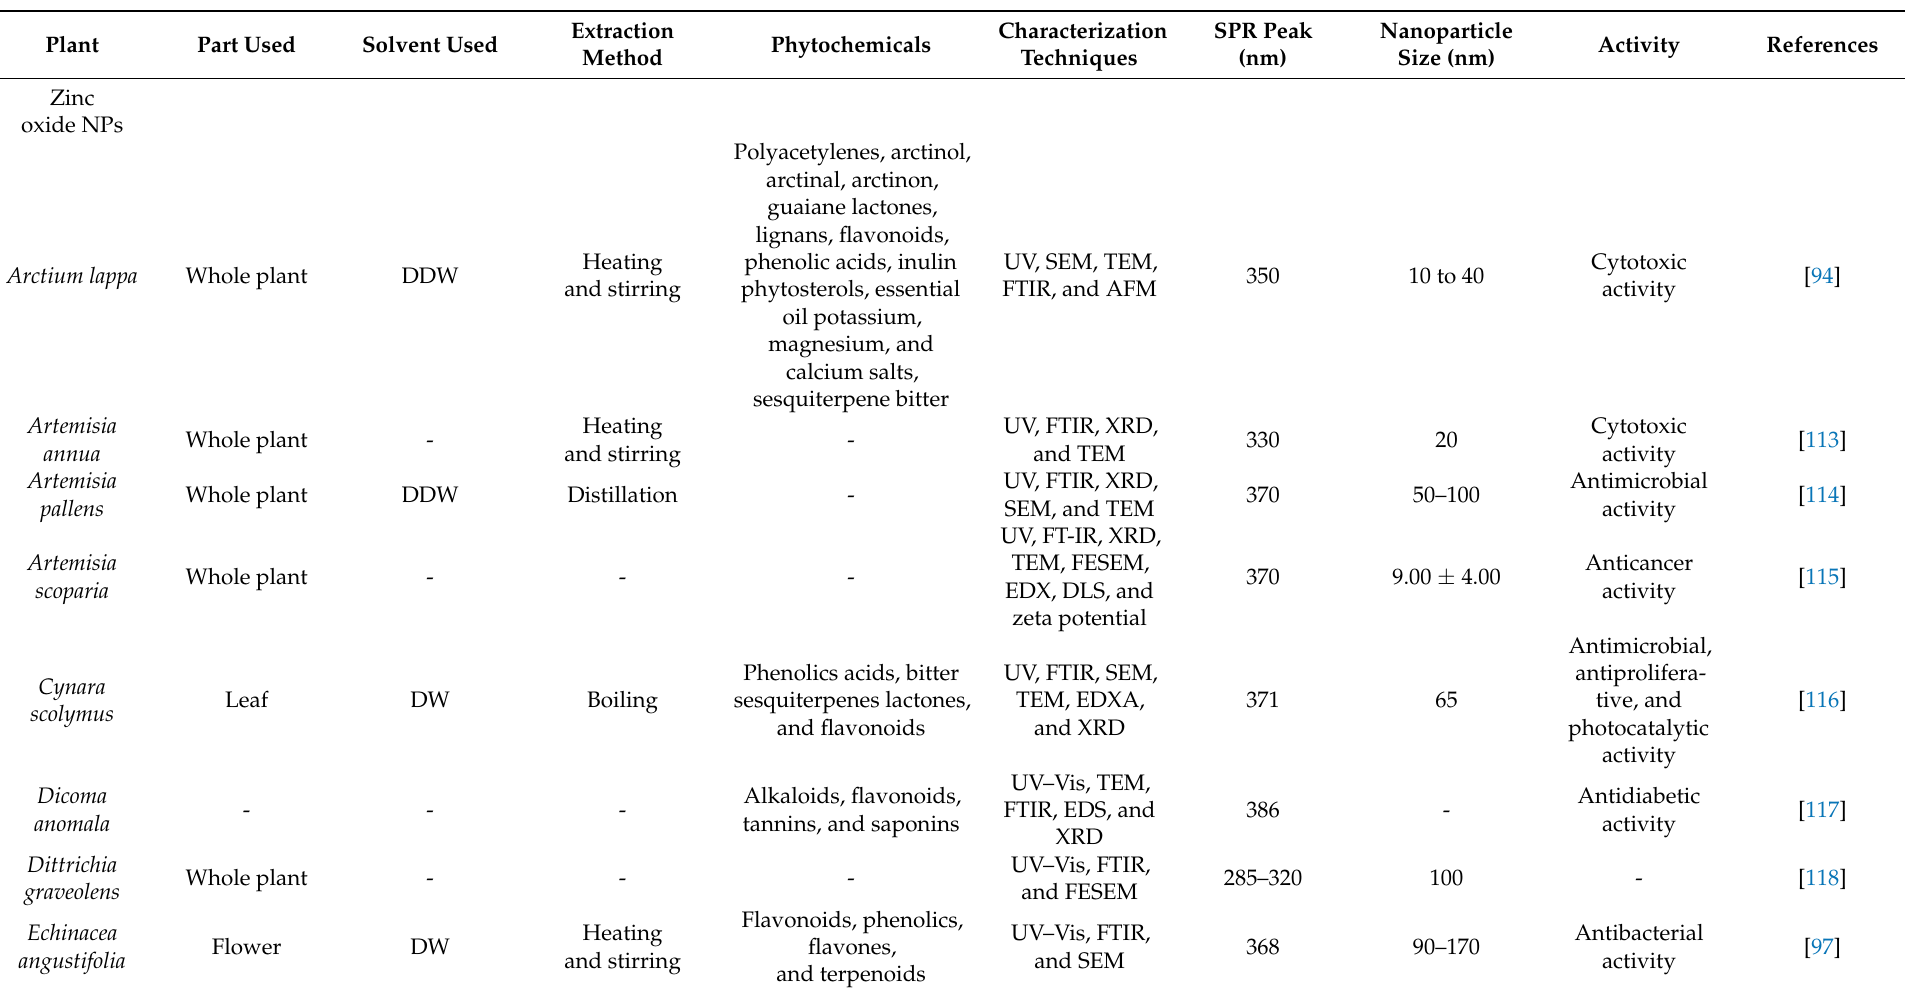
Table 2. Studies carried out to synthesize metal oxide nanoparticles from Asteraceae family and their biological